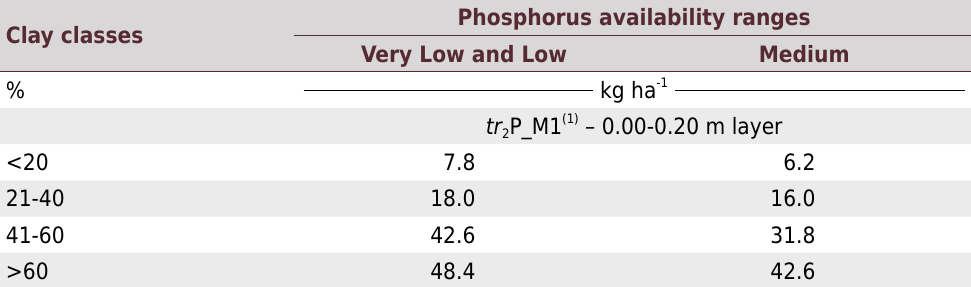
Table 4. The tr 2 P_M1 values, according to clay classes and phosphorus availability ranges, for the recommendation of correction phosphate fertilization in the soils of Rio Grande do Sul